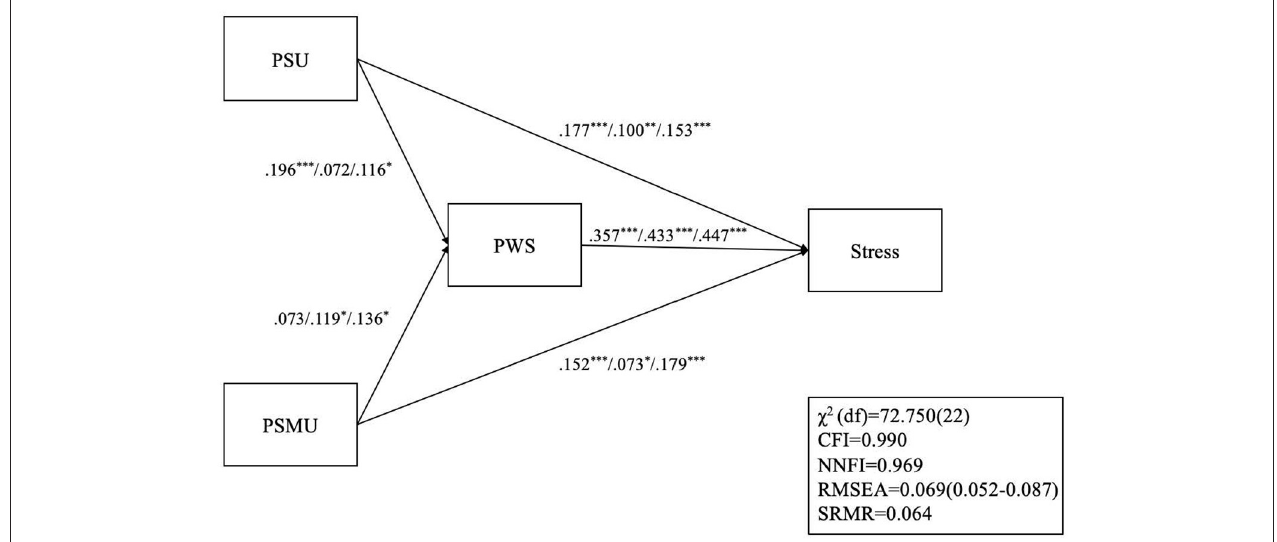
FIGURE 3 | Structural equation modeling with multiple group analysis on the relationship among PSU, PSMU, PSW, and stress. * p < 0.05; ** p < 0.01; *** p < 0.001; For each set of path coefficients, the first coefficient represents pre-COVID associations (Wave 1); the second coefficient represents associations during the COVID outbreak (Wave 2); the last coefficient represents post-COVID lockdown (Wave 3) associations; PSU, problematic smartphone use; PSMU, Problematic social media use; PWS, perceived weight stigma; CFI, Comparative fit index; NNFI, non-normed fit index; RMSEA, root mean square error of approximation; SRMR, standardized root mean square